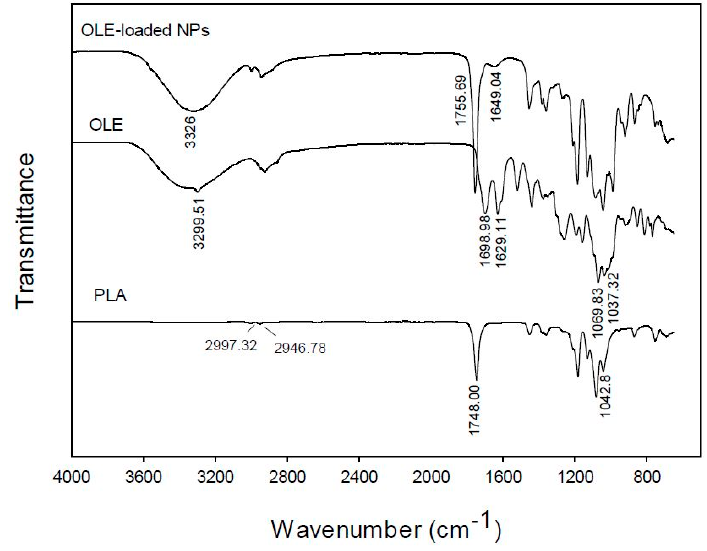
Figure 6. FT-IR (ATR) spectra of pure poly(lactic acid) (PLA), olive leaves extract (OLE), and PLA nanoparticles loaded with olive leaves extract (OLE-loaded NPs).